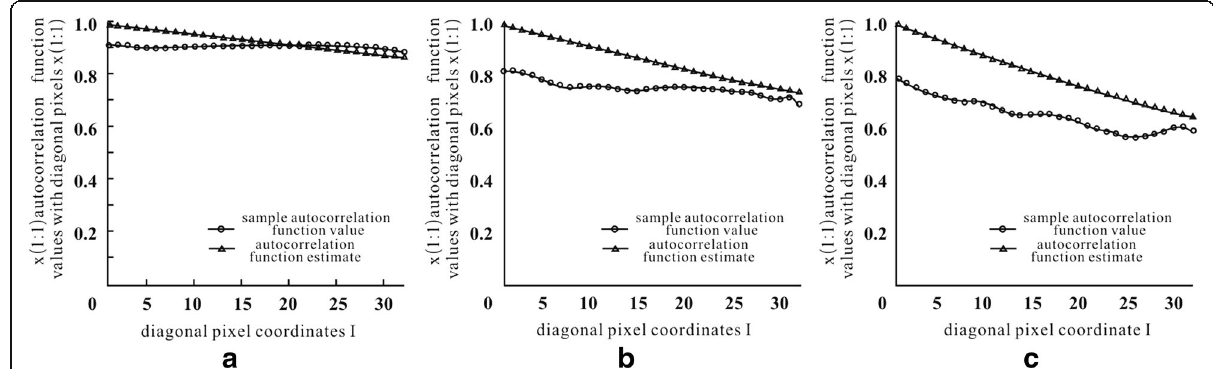
Fig. 4 Comparison of the autocorrelation function estimate and sample autocorrelation function value. a Flat blocks. b Edge blocks. c Texture block